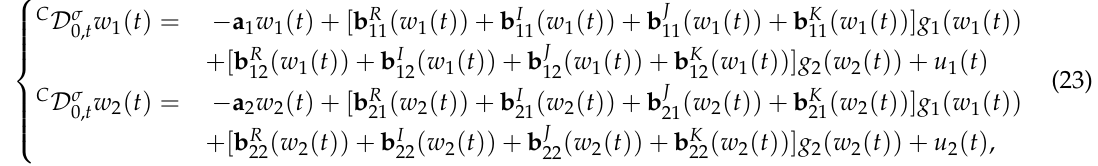
( t ) , w K ( t ) of systems (22) in Example 2 1